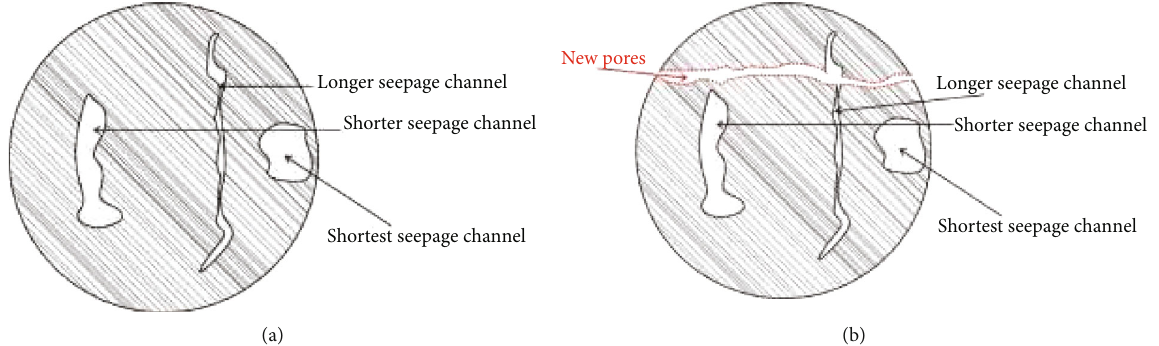
Figure 3: Pores with di ff erent seepage channels in the rock: (a) before breakage; (b) after